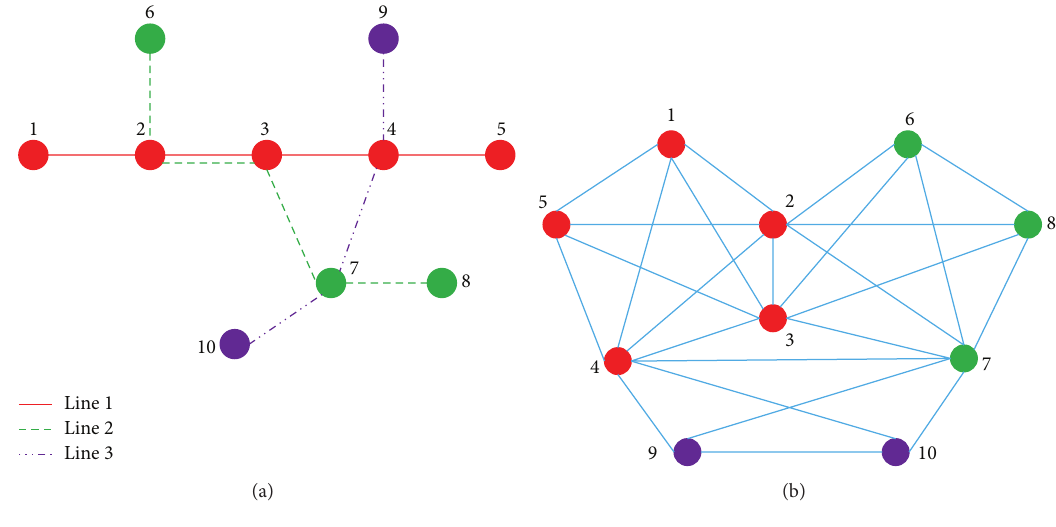
Figure 1: Simple bus network described by Space